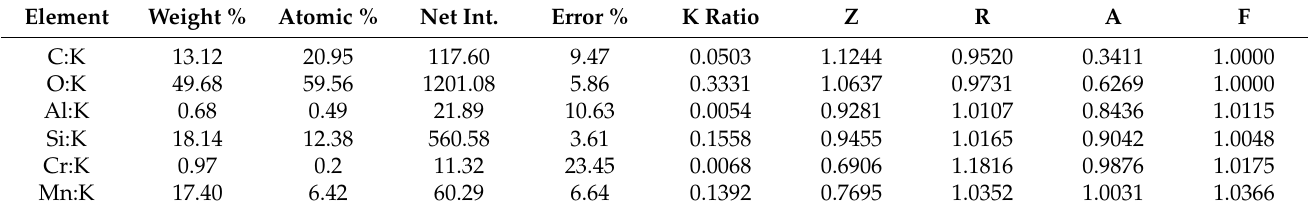
Table 6. Chemical composition as the result of EDS analysis in specimen No. 5 (second